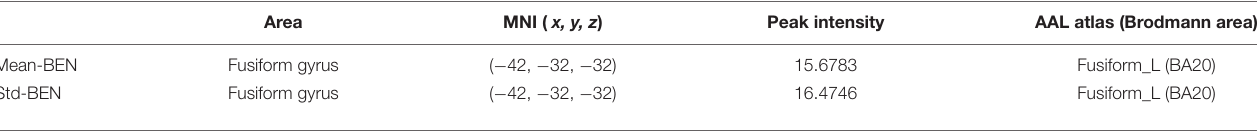
TABLE 5 | MNI coordinates of positively activated brain regions and related brain regions (seafarers’ brain entropy value > non-seafarers’ brain entropy value, Len = 80 TRs, AlphaSim correction, p < 0.05 with cluster size > 210